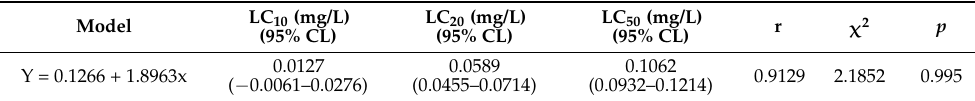
Table 2. Acute toxicity of EMB against FAW third instar larvae 24 h